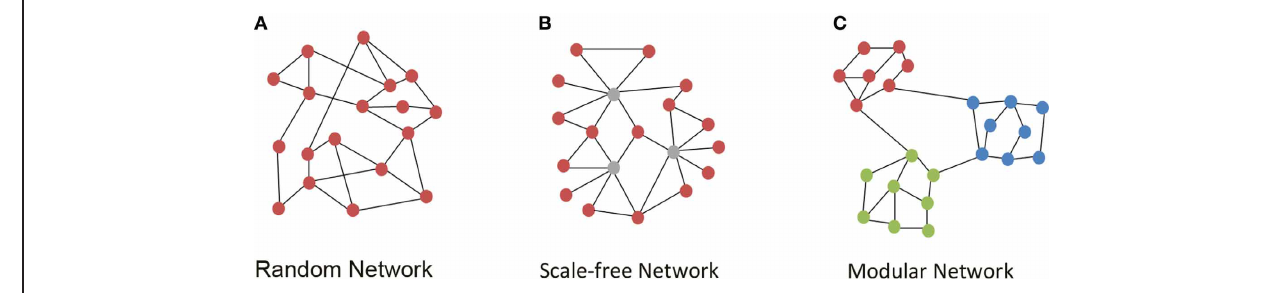
FIGURE 1 | Network topologies. (A) An example of a random network with no high degree hubs, where nodes (red circles) are connected by edges (black lines). (B) A scale-free network with high degree hubs (gray circles).